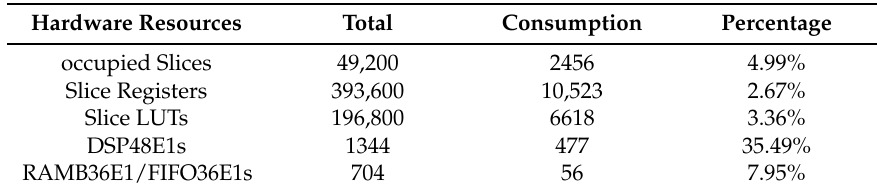
Table 1. Hardware resources consumption.